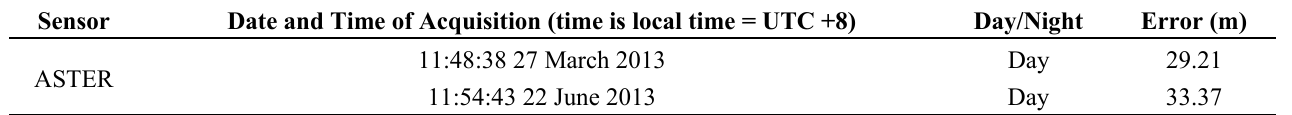
Table 3. Error values for VNIR images to GPS points